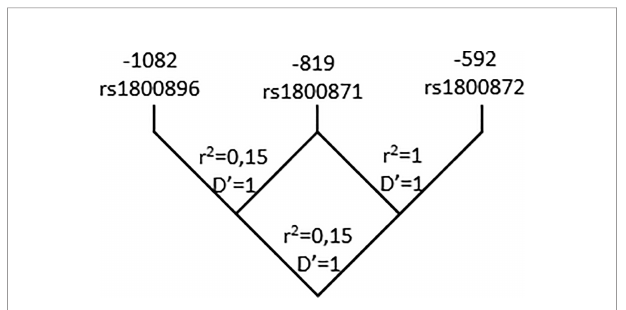
FIGURE 1 | Pairwise LD map for SNPs rs1800896; rs1800871; rs1800872 across IL-10 region. Lewontin ’ s D ’ measure and r 2 values of LD are shown.